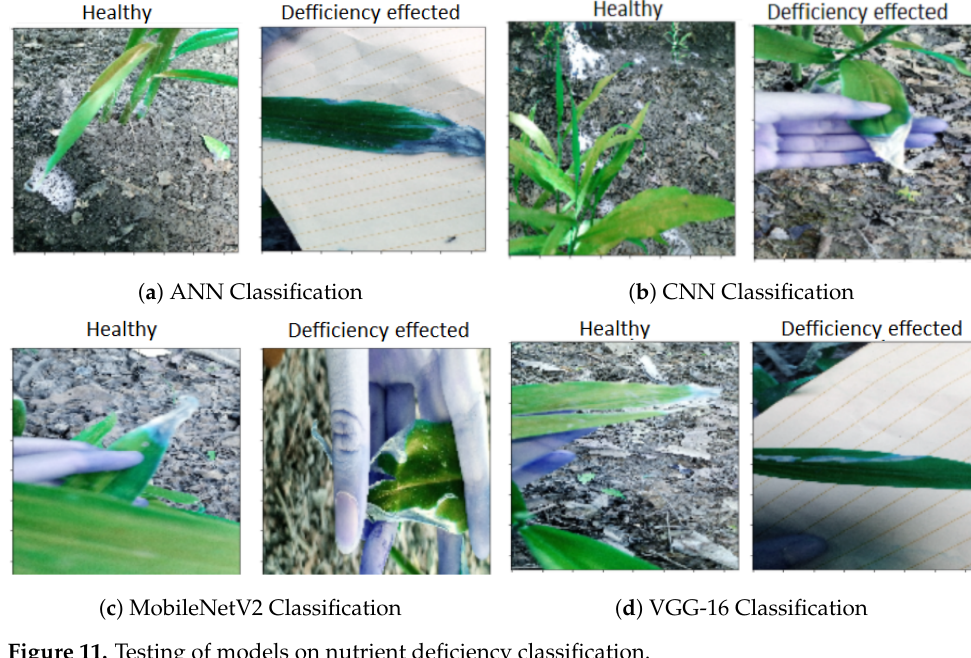
Figure 11. Testing of models on nutrient deficiency classification.